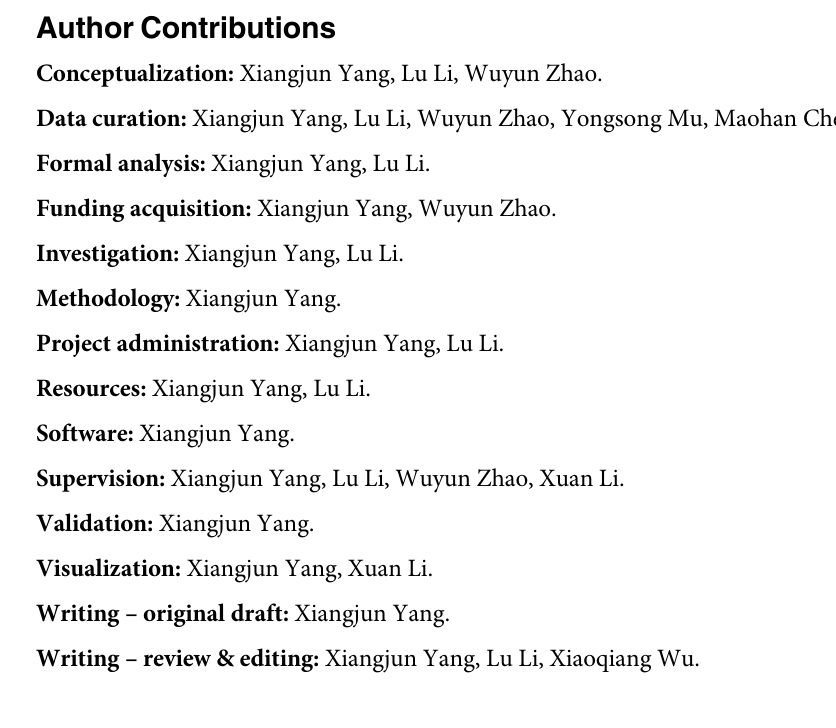
S6 Table. The silage corn yields under CDLM, PE films and CK in 2018, 2019 and 2020. S7 Table. The silage corn yields and water use efficiency (WUE) under CDLM, PE films and CK in 2018, 2019, and